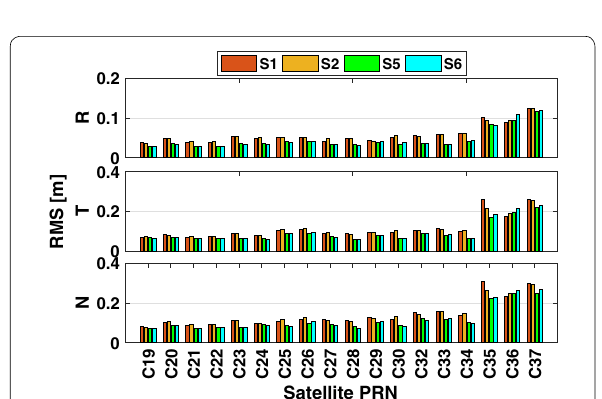
Fig. 6 GPS average clock accuracy of per POD